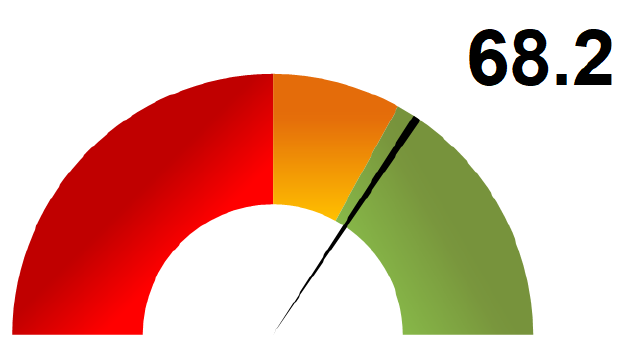
Figure 3. Overall weighted score (range: 0 to 100). The scale was arbitrarily divided into three parts: red—overall weighted score less than 50; yellow—overall weighted score between 50 and 66; green—overall weighted score above 66.